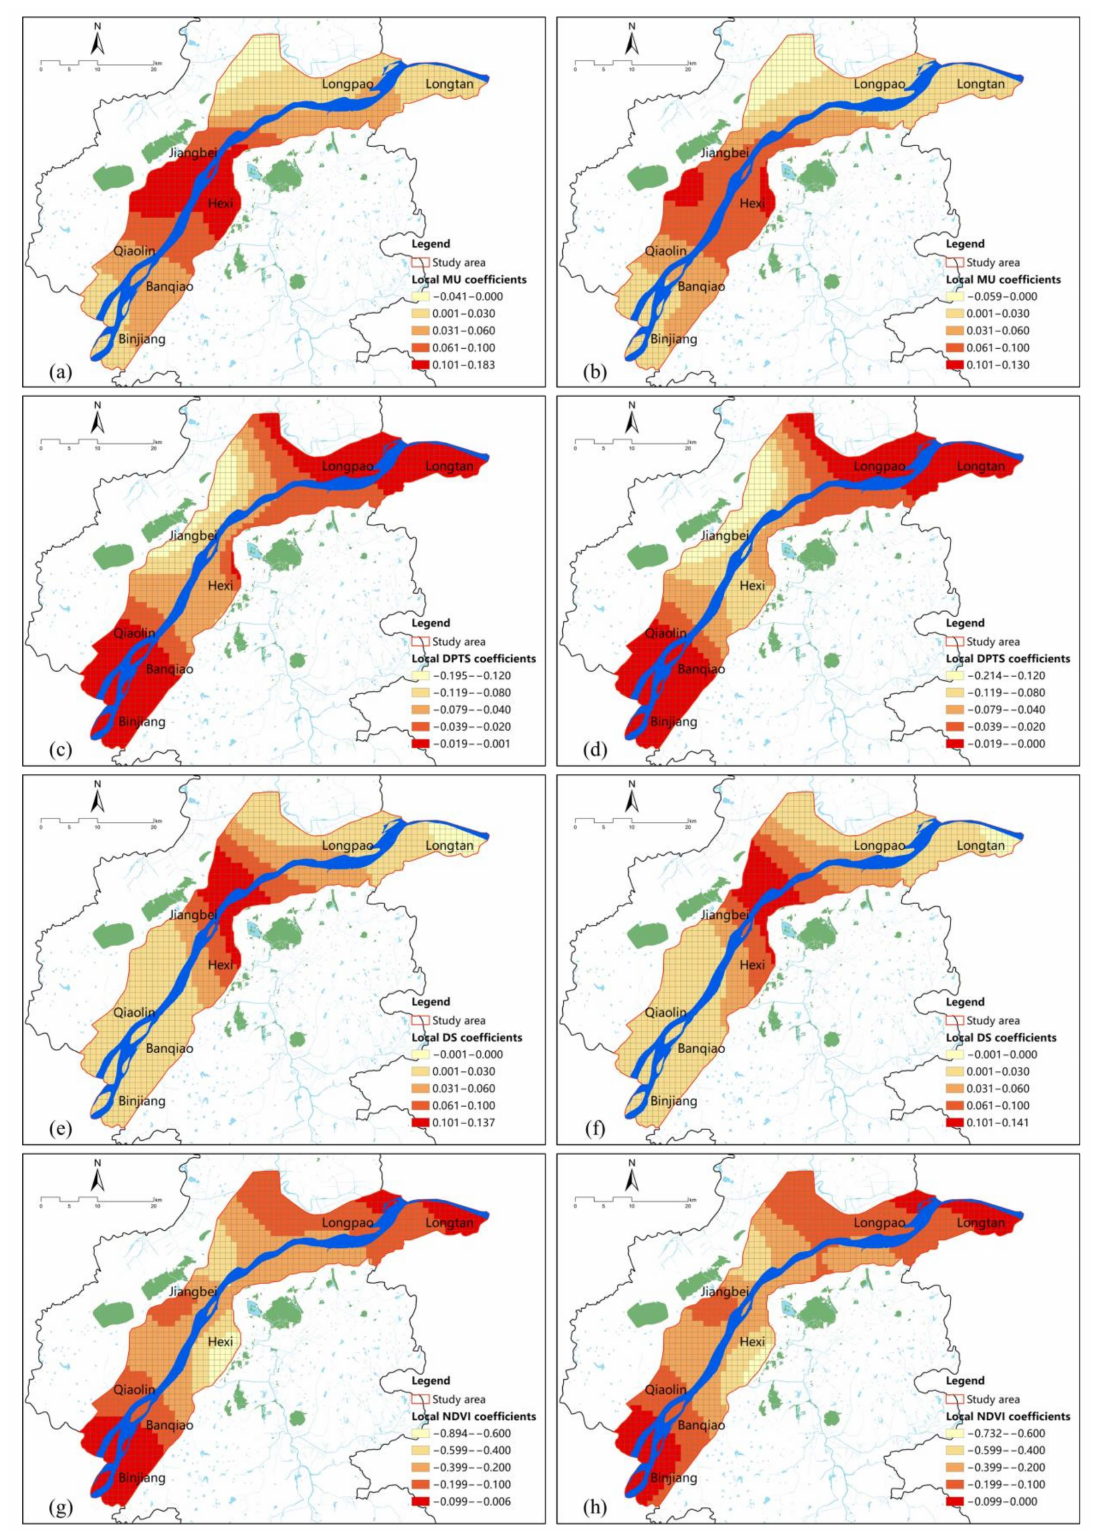
Figure 6. Continued: ( a ) local MU coefficients on weekdays; ( b ) local MU coefficients on weekends; ( c ) local DPTS coefficients on weekdays; ( d ) local DPTS coefficients on weekends; ( e ) local DS coefficients on weekdays; ( f ) local DS coefficients on weekends; ( g ) local NDVI coefficients on weekdays; ( h ) local NDVI coefficients on